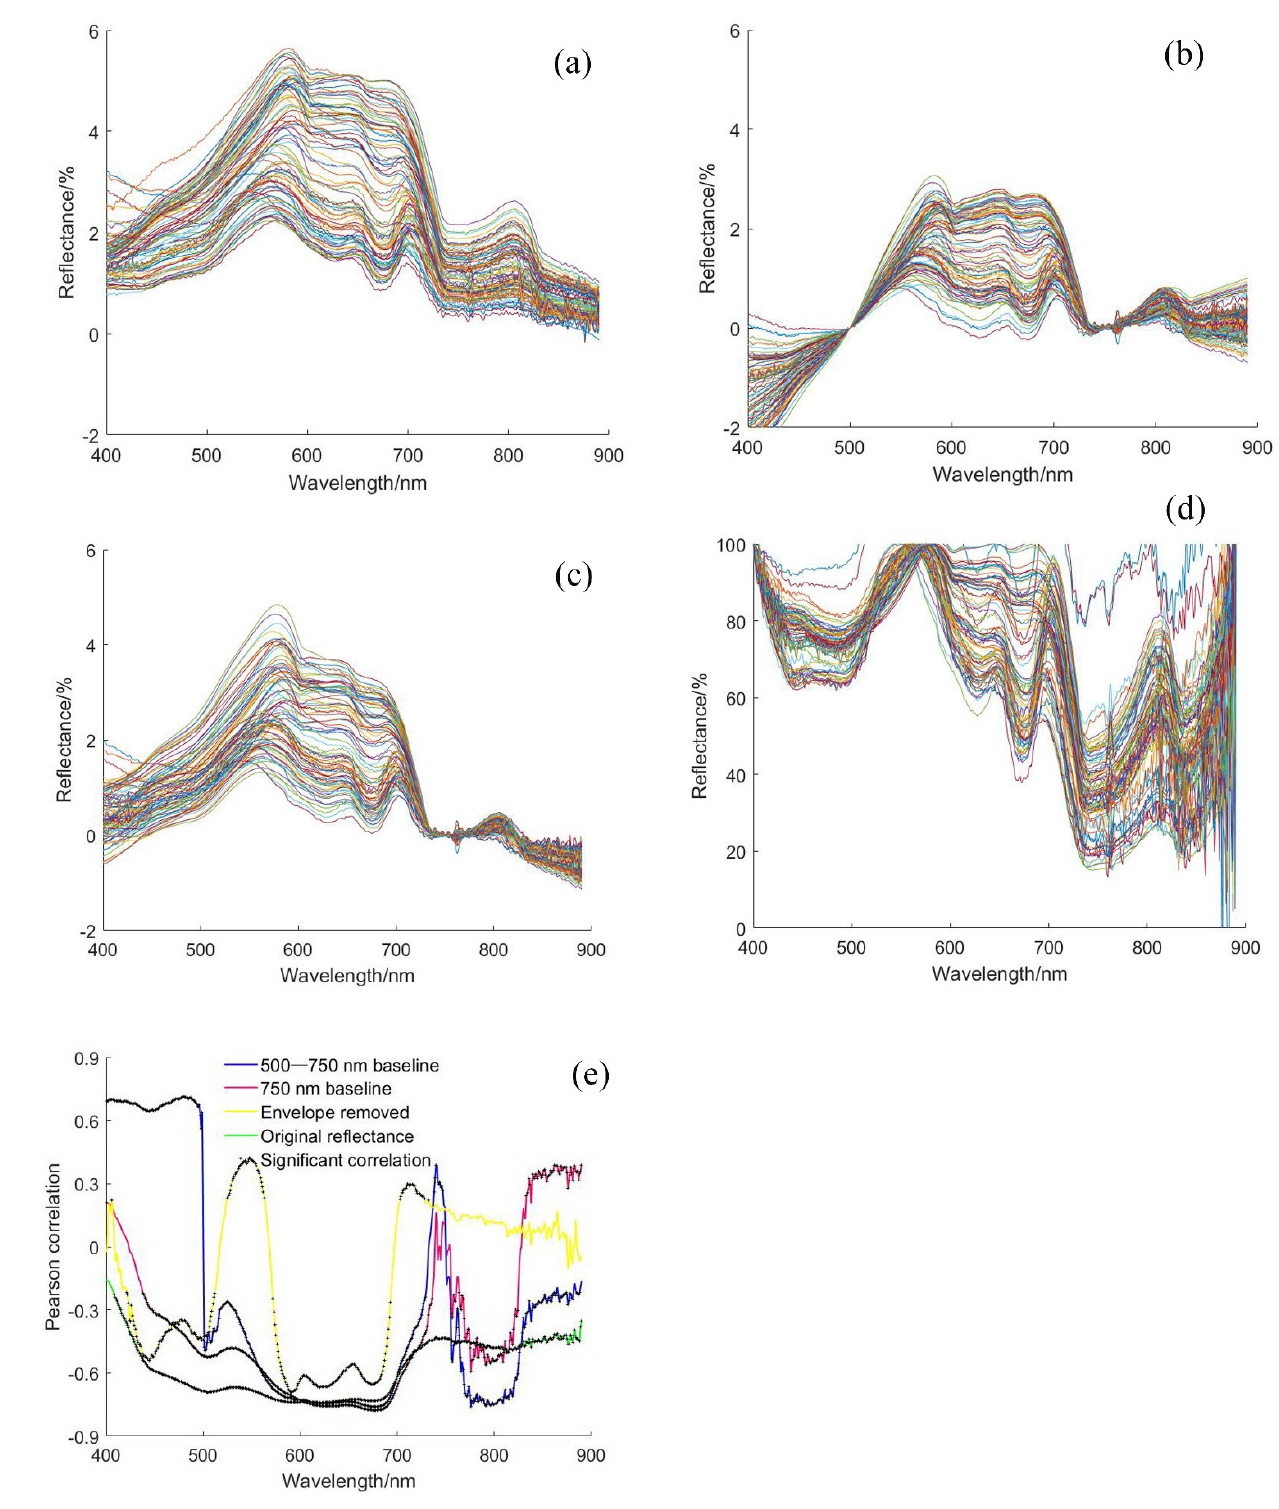
Figure 2. Spectral curve characteristics. ( a ) Original spectrum. ( b ) Baseline spectrum at 500–750 nm. ( c ) Baseline spectrum at 750 nm. ( d ) Envelope removal spectrum. ( e ) Correlation analysis. at 750 nm. ( d ) Envelope removal spectrum. ( e ) Correlation